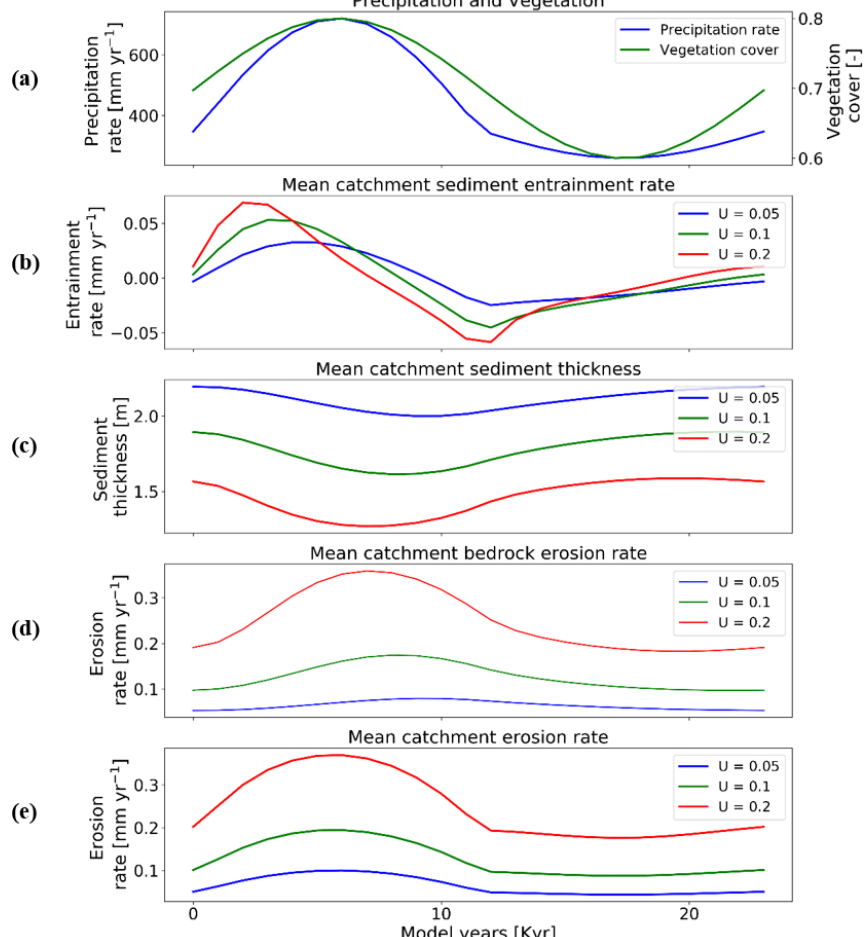
Figure 11. Temporal evolution of catchment-averaged predictions for scenario 5 described in the text (Sect. 3.5). Graphical representation of mean catchment sedimentation and erosion with different rates of rock uplift [mma − 1 ] to (a) coupled oscillations in precipitation [mmyr − 1 ] and vegetation cover [–] in terms of (b) sediment entrainment [mmyr − 1 ], (c) sediment thickness [m], (d) bedrock erosion [mmyr − 1 ], (e) mean erosion rates [mmyr − 1 ] for entire catchment. The periodicity of climate and vegetation oscillations is 23kyr. The simulations represent 70% initial vegetation